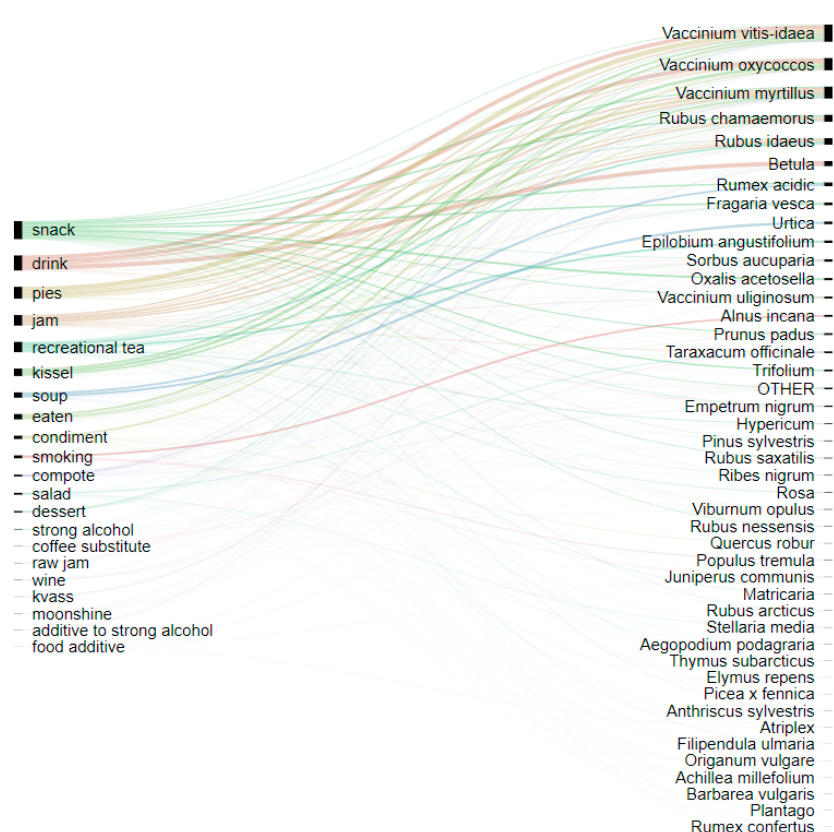
Figure 2. Alluvial diagram showing the relationships between foods made and taxa based on DURs during the lifetime of interviewees.